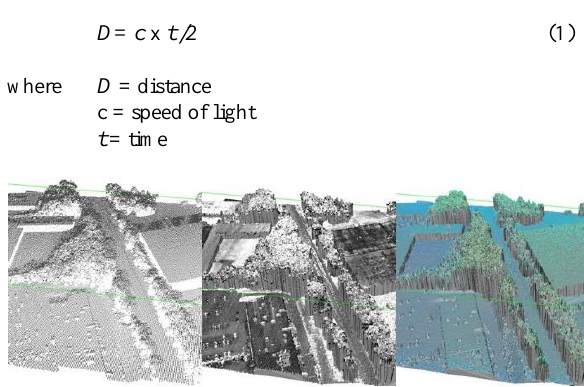
Figure 4. LiDAR point cloud processing using LAStools software